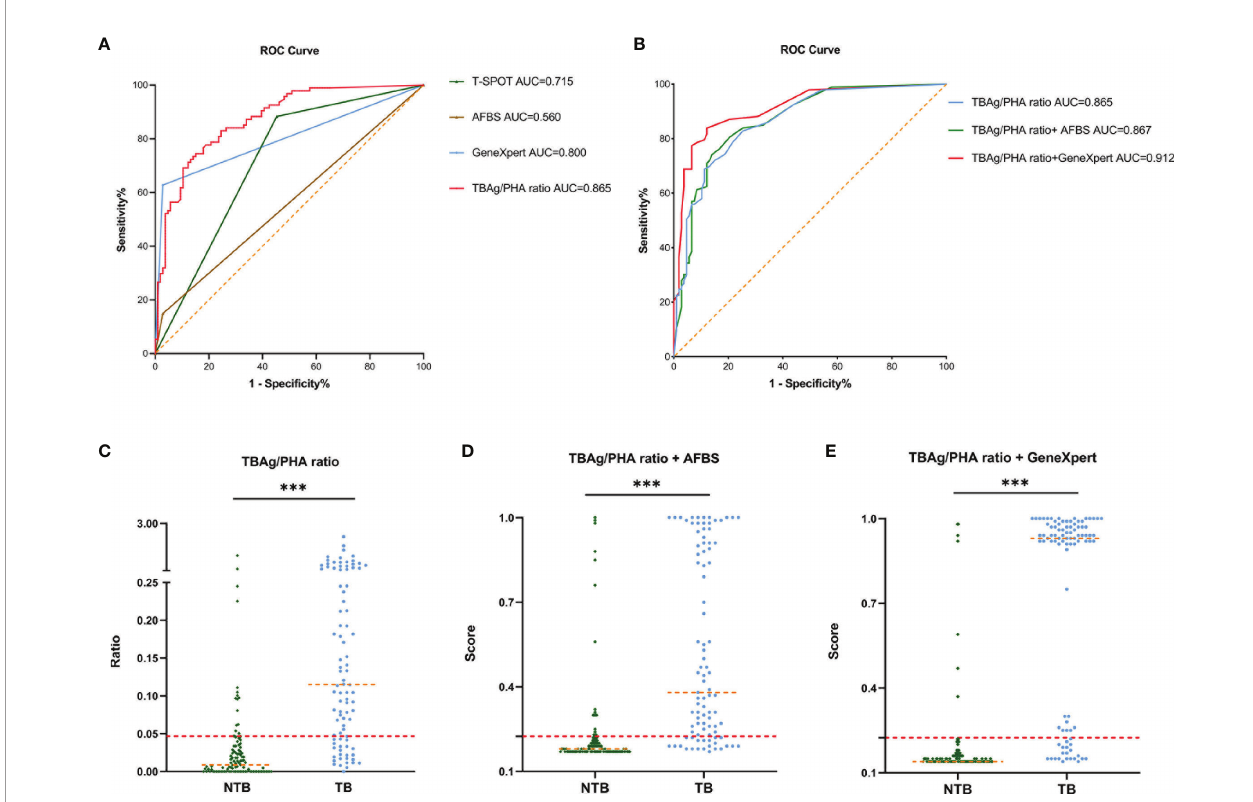
FIGURE 3 | Validation of ROC curve of different tuberculosis tests and diagnostic models in the Sino-French New City Hospital cohort. (A) ROC analysis showing the performance of T-SPOT, AFBS, GeneXpert MTB/RIF, and TBAg/PHA ratio. (B) ROC analysis displaying models for the diagnosis of spinal tuberculosis based on the TBAg/PHA ratio or in combination with AFBS or GeneXpert MTB/RIF. (C) Scatter plots showing the ratio of TBAg/PHA in spinal tuberculosis patients (n = 93) and no spinal tuberculosis patients (n = 107). Orange dotted lines representing the median value. Red dotted lines indicating the cutoff value in distinguishing these two groups. ***p < 0.001 (Mann – Whitney U-test). (D) Scatter plots showing the score of the diagnostic model based on TBAg/PHA ratio combined with AFBS in spinal tuberculosis patients (n = 93) and no spinal tuberculosis patients (n = 107). Orange dotted lines representing the median. Red dotted lines indicating the cutoff value in distinguishing these two groups. ***p < 0.001 (Mann – Whitney U-test). (E) Scatter plots showing the score of the diagnostic model based on TBAg/PHA ratio combined with GeneXpert MTB/RIF in spinal tuberculosis patients (n = 93) and no spinal tuberculosis patients (n = 107). Orange dotted lines representing the median. Red dotted lines indicating the cutoff value in distinguishing these two groups. ***p < 0.001 (Mann – Whitney U-test). ROC, receiver operating characteristic; AUC, area under the curve; AFBS, acid-fast bacilli smear; MTB, Mycobacterium tuberculosis ; RIF, rifampicin resistance; TBAg, Mycobacterium tuberculosis -speci fi c antigen; PHA,